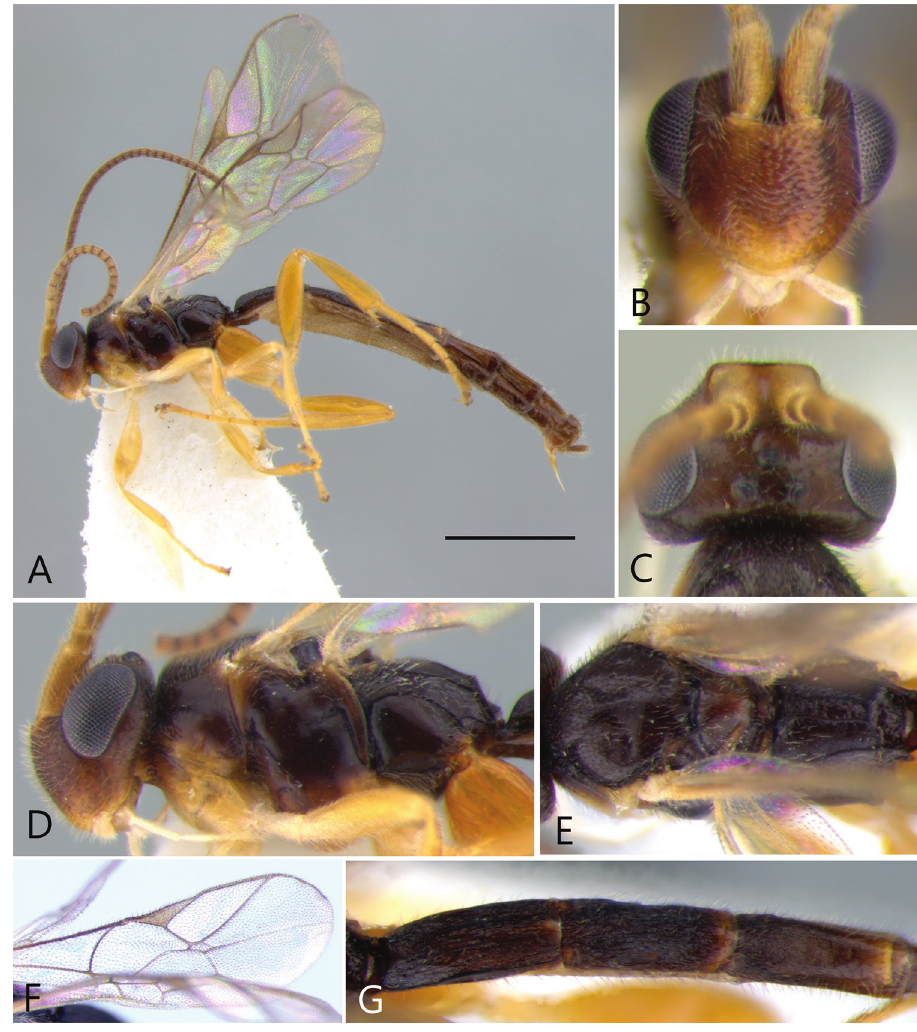
Figure 16. Orthocentrus tenuiventris sp. nov. Holotype. A Habitus in lateral view B head in frontal view C head in dorsal view D head and mesosoma in lateral view E mesosoma in dorsal view F fore wing G first to third tergites in dorsal